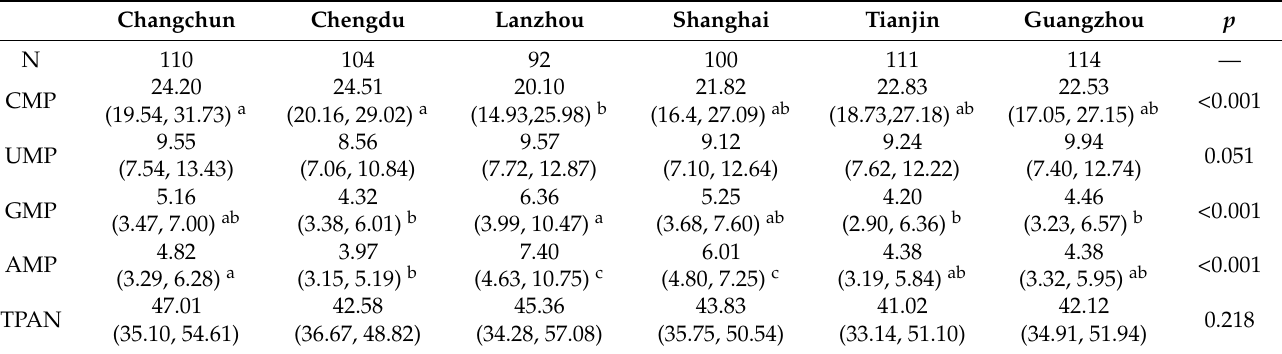
Table 3. Comparison of TPAN contents in the 6 regions [mg/L, Median (P25, P75)].